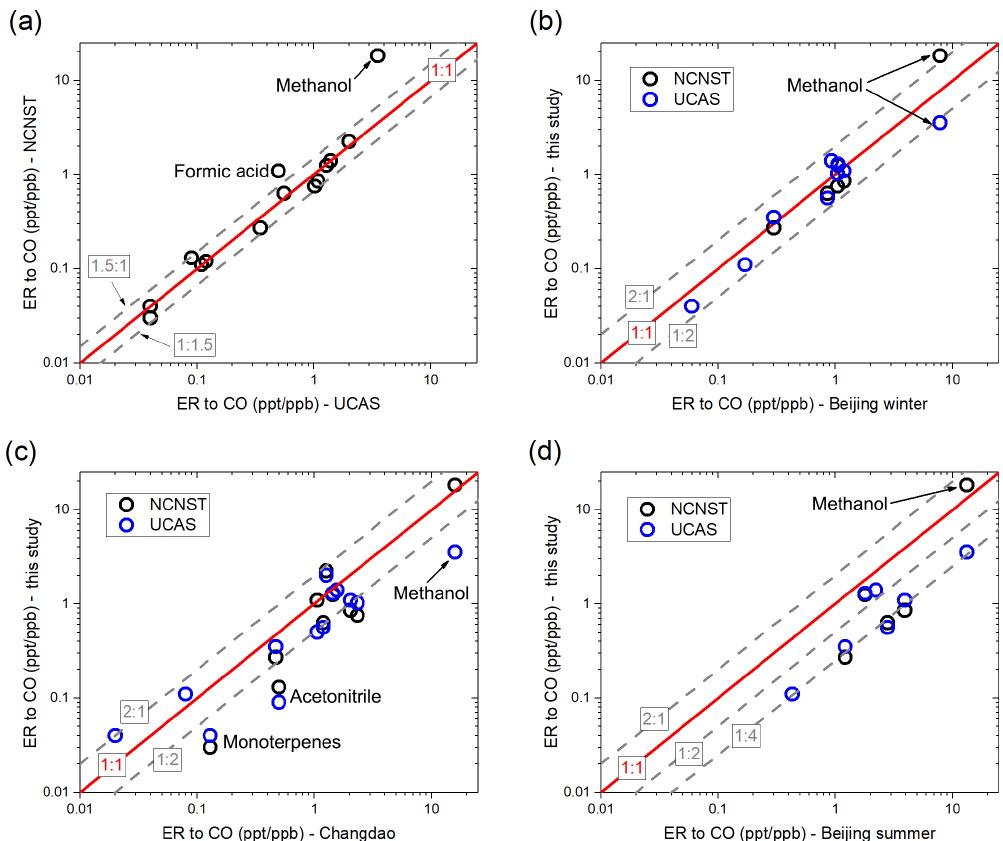
Figure 7. Comparison of VOC emission ratios relative to CO. (a) NCNST site vs. UCAS site of this study; (b) this study vs. urban Beijing winter (Wang et al., 2014); (c) this study vs. Changdao (Yuan et al., 2013); (d) this study vs. urban Beijing summer (Yuan et al.,